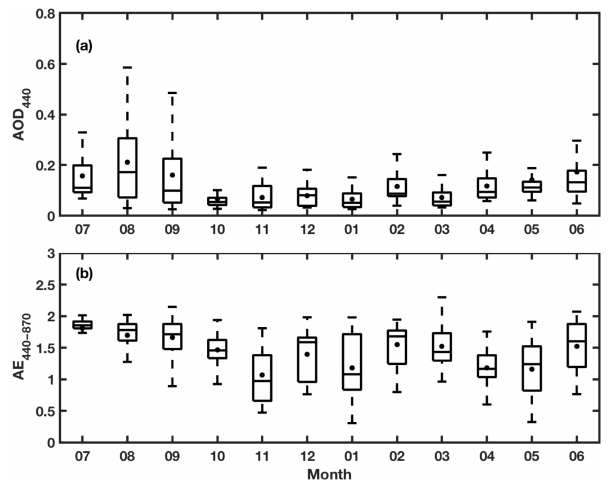
Figure 2. Monthly variations in (a) aerosol scattering coefficient at 450nm ( σ 450 ) for total (in blue, particle diameter, D p , less than 10µm) and fine-mode (in red, D p less than 1µm) aerosol parti- cles and (b) aerosol particle number concentration ( N a ) . Box-and- whisker plots include median values (horizontal lines inside boxes), 25th and 75th percentiles (ends of boxes), 5th and 95th percentiles (ends of whiskers), and mean values (black dots). Months from left to right start at July 2012 and end at June 2013.